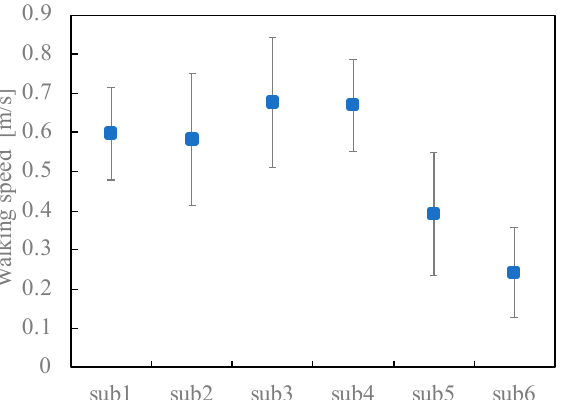
Figure 6. Comparison of the ascent speed between participants. Blue circles and error bars indicate the mean values and standard deviations, respectively.